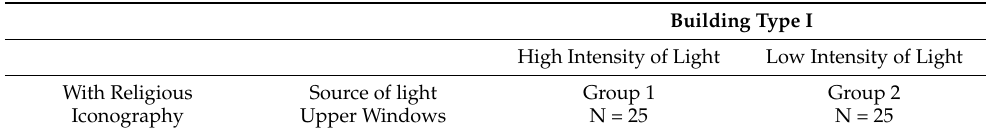
Table 1. 2 × 2 Experimental design for the experiment: case